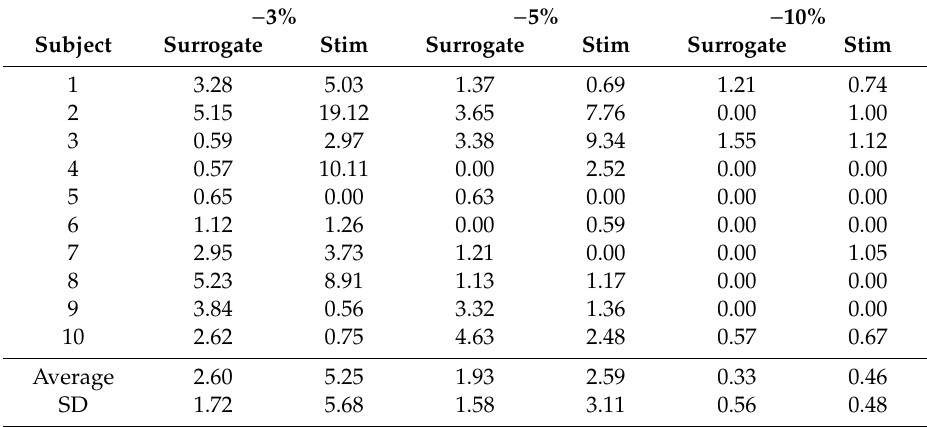
Table 3. Summary of the synchronization ratio under each set of stimulation